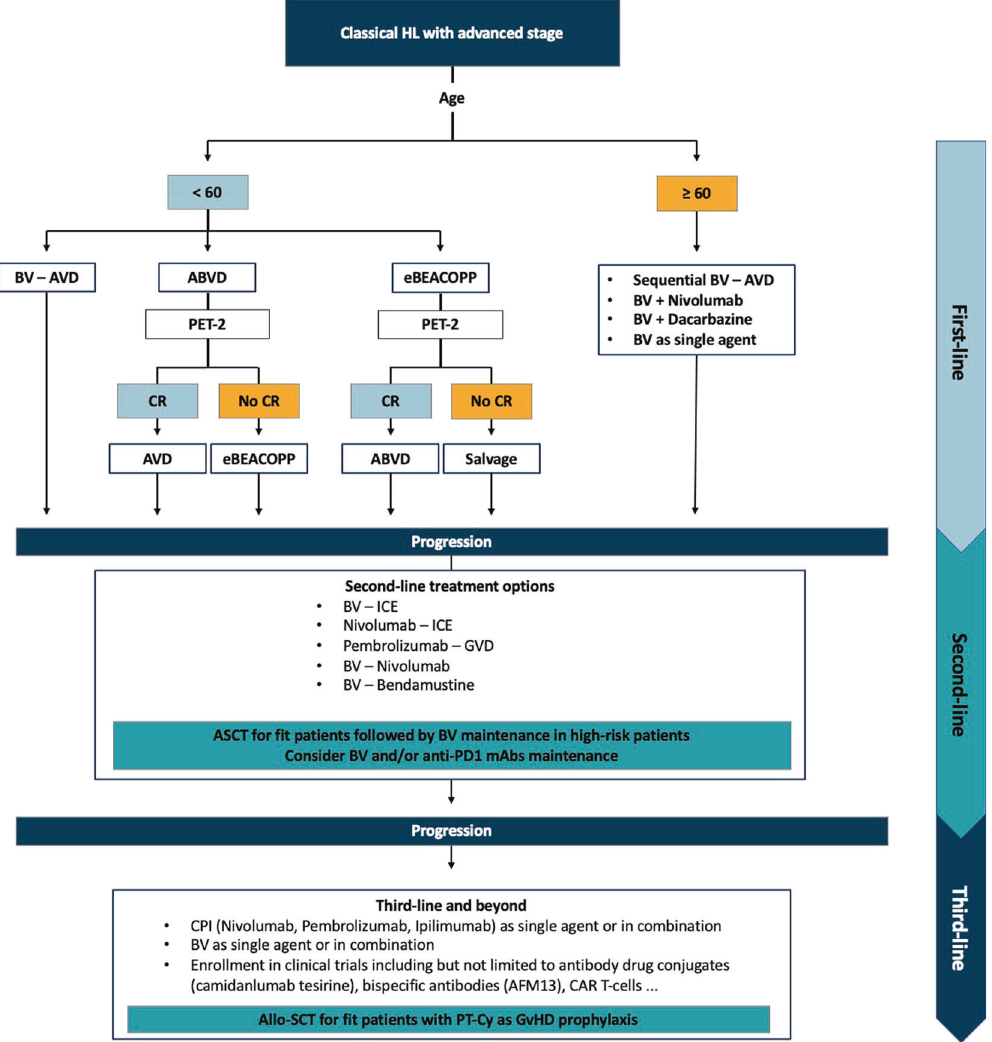
Fig. 1 Suggested treatment algorithm for advanced-stage classical Hodgkin Lymphoma. In the frontline setting, patients are treated according to age. In patients aged <60 years, the treatment options can be either immunotherapy (BV) combined with AVD or risk-adapted PET-guided approaches using ABVD and/or eBEACOPP. In patients aged >60 years, the intensity of therapies should be adapted to comorbidities. In the relapsed setting, chemoimmunotherapeutic or chemotherapy-free approaches can be used. ASCT is recommended for fi t patients followed by BV maintenance for high-risk patients (a shorter duration of BV or the use of anti-PD1 mAbs alone or in combination with BV may be considered). Beyond third-line therapy, immunotherapy can be used as single agent or in combination. Also, patients can be included in clinical trials using novel agents or cellular therapy. Allo-SCT remains the standard of care for fi t and responding patients. PT-Cy should be considered as GvDH prophylaxis for all patients undergoing allo-SCT, even in the non-haploidentical settings. HL : Hodgkin Lymphoma; ABVD : Adriamycin, Bleomycin, Vincristine, Dacarbazine; eBEACOPP : bleomycin, etoposide, doxorubicin (aka adriamycin), cyclophosphamide, vincristine (aka oncovin), procarbazine, prednisolone; PET : positron emission tomography; BV : brentuximab vedotin; AVD : Adriamycin, Vincristine, Dacarbazine; GVD : gemcitabine, vinorelbine, liposomal doxorubicin; CR : complete response; ICE : ifosfamide, mesna, carboplatin, etoposide; ASCT : autologous stem cell transplantation; PD1 : programmed cell death 1; mAbs : monoclonal antibodies; CPI : checkpoint inhibitors; Allo-SCT : allogeneic stem cell transplantation; PT-Cy : post-transplant cyclophosphamide; GvHD : graft-versus-host various HRQoL domains. The effects of treatment on QoL can vitality. Time since diagnosis, types of primary treatment, and really jeopardise a patient ’ s return to normal life, with familial, relapse, were not associated with statistically signi fi cant differ- social, and professional consequences. There are many guidelines ences in HRQoL [72]. to help with the treatment of cHL resulting from numerous In the H8 randomized trial, HRQoL data from 935 patients after randomized controlled trials, but the patient cure does not just treatment for early stage cHL showed strain and limitations in all depend on prescribing the right treatment. Emphasis on HRQoL subdomains apart from cognitive functioning, and also reduced following therapy may inform treatment decisions and long-term motivation. Differences in HRQoL improvement with time were survivorship goals. To improve HRQoL, clinicians need to learn linked to age and sex, but not the type of treatment. Fatigue status more about the impact of treatments on HRQoL. Future research at the end of treatment seems to predict subsequent HRQoL [73]. should include prospective, longitudinal randomized trials across Persistent fatigue represents one of the greatest challenges in both treatments and time. They also need to gain further insight cHL and efforts should be made to identify the contributing into the course of recovery after cure, considering all aspects of factors and better describe the patterns of recovery within the